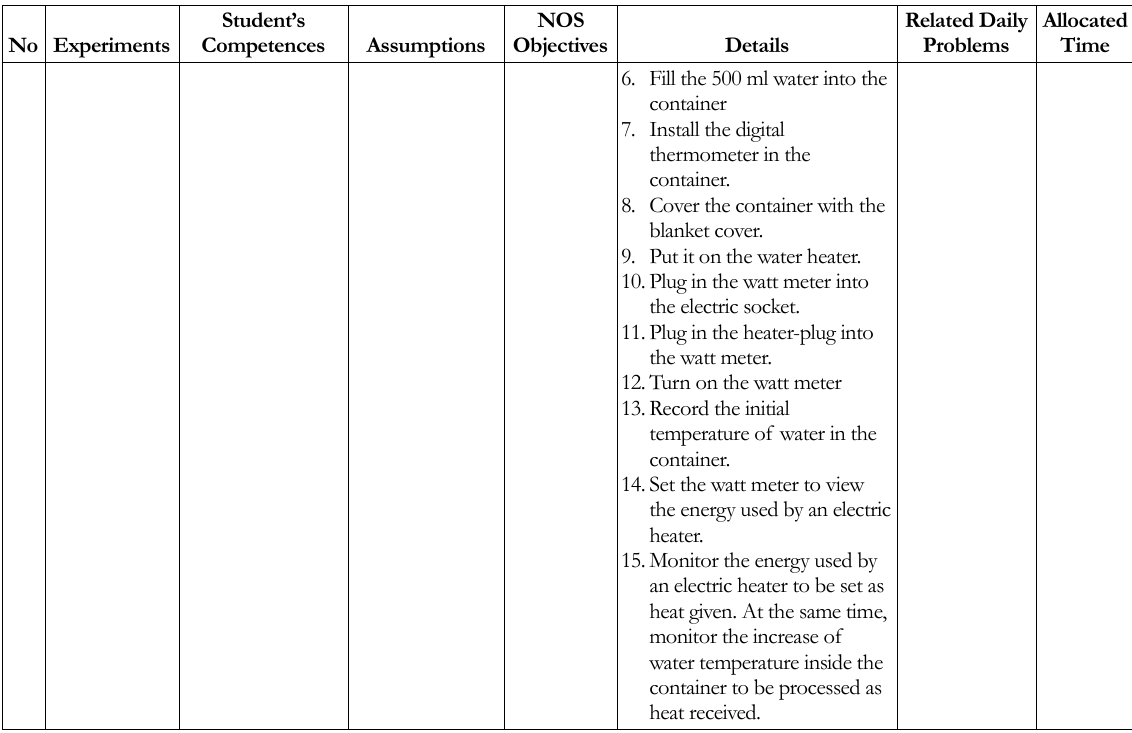
Table 2. The complete experiment designs on heat and temperature supporting the student’s nature of